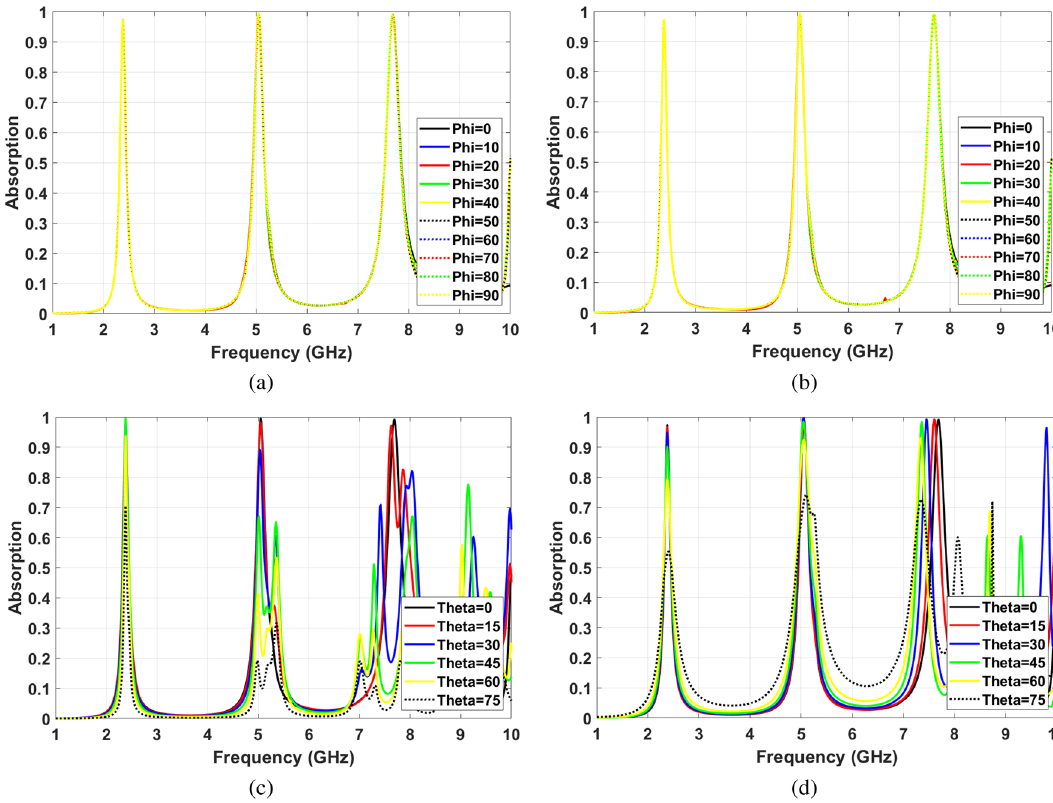
Figure 9. Angle insensitivity ( a ) Different polarization angles for TE waves, ( b ) Different polarization angles for TM waves, ( c ) Different incident angles for TE waves, ( d ) Different incident angles for TM